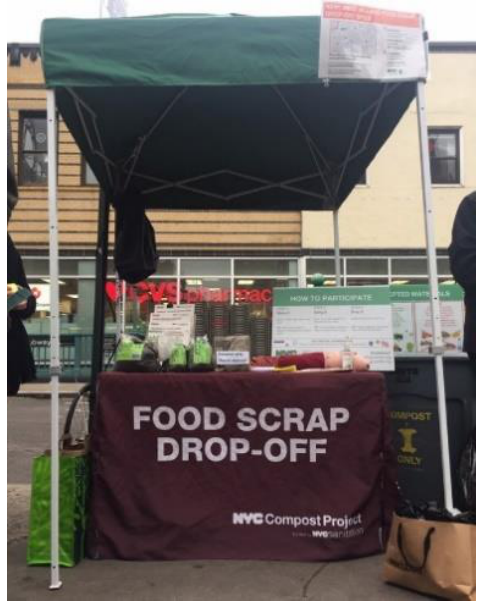
Figure 4. One of 150 drop-off locations in Manhattan, US. [95].